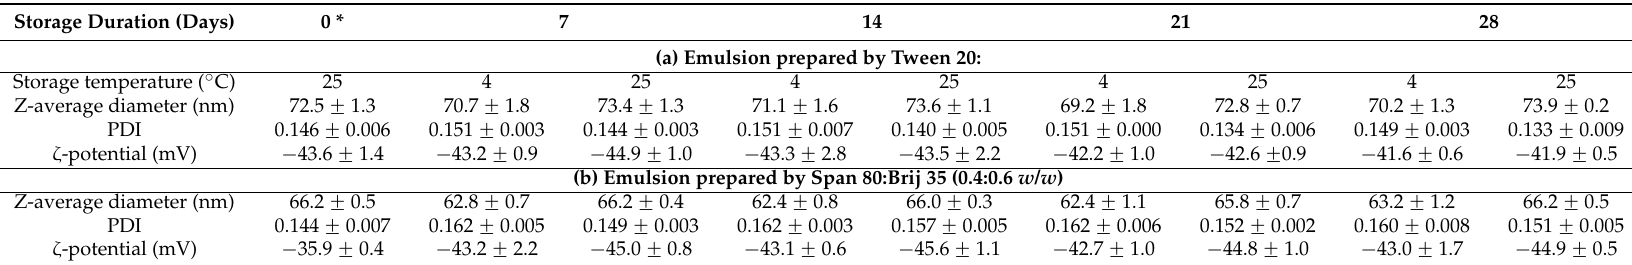
Table 3. Stability of nanoemulsion prepared by Tween 20 and emulsifier combination Span 80:Brij 35 stored under temperature of 4 ˝ C and 25 ˝ C respectively (mean ˘ S.D., n =